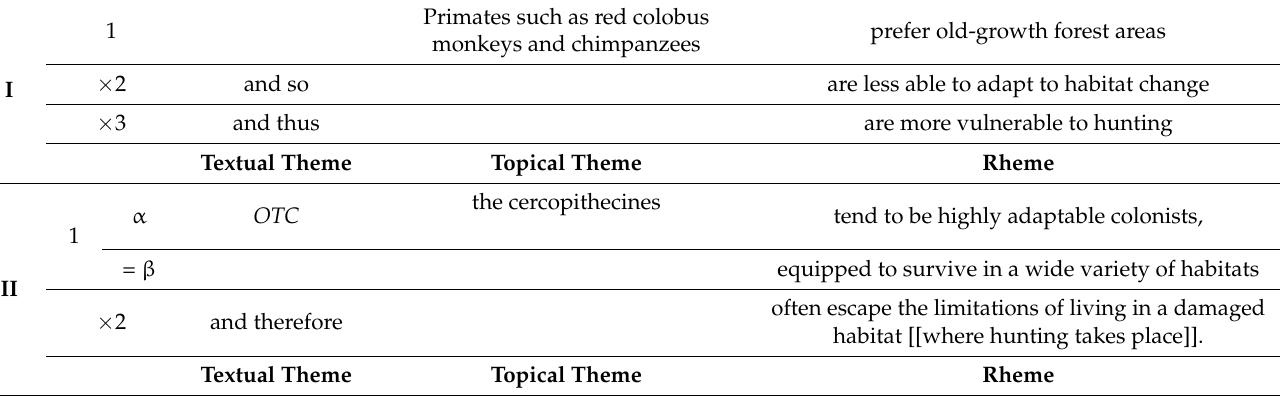
Table 3. Analysis of example (3) in terms of logico-semantic relations and thematic